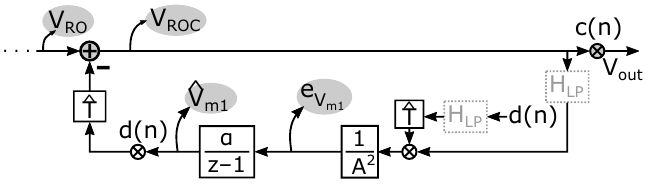
Figure 8. Detailed representation of one spread-spectrum offset reduction